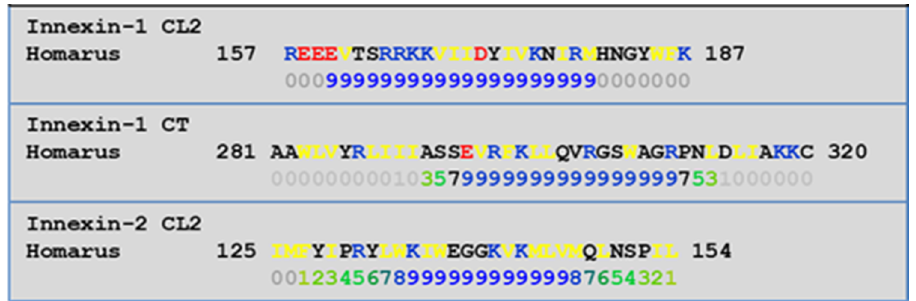
Figure 3. Innexins’ CaM-binding sites at CL2 and CT domain.